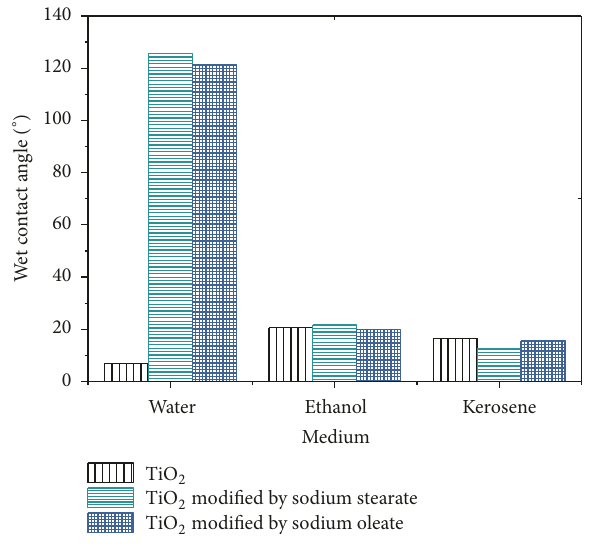
Figure 3: Change of wet contact angle of TiO 2 .